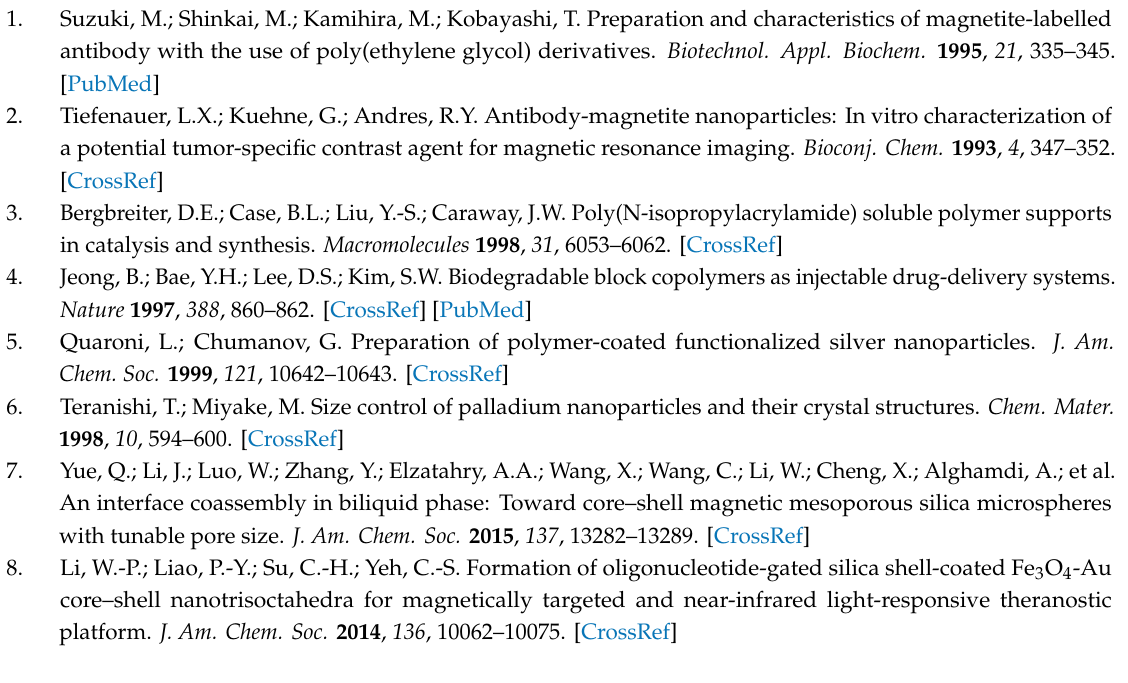
Figure S2: EDX spectrum of the GNS@ m -SiO 2 @hydrogel NPs; Figure S3: UV-vis spectra of (a) GNSs, (b) GNS@SiO 2 , (c) GNS@ m -SiO 2 , and (d) GNS@ m -SiO 2 @hydrogel under neutral